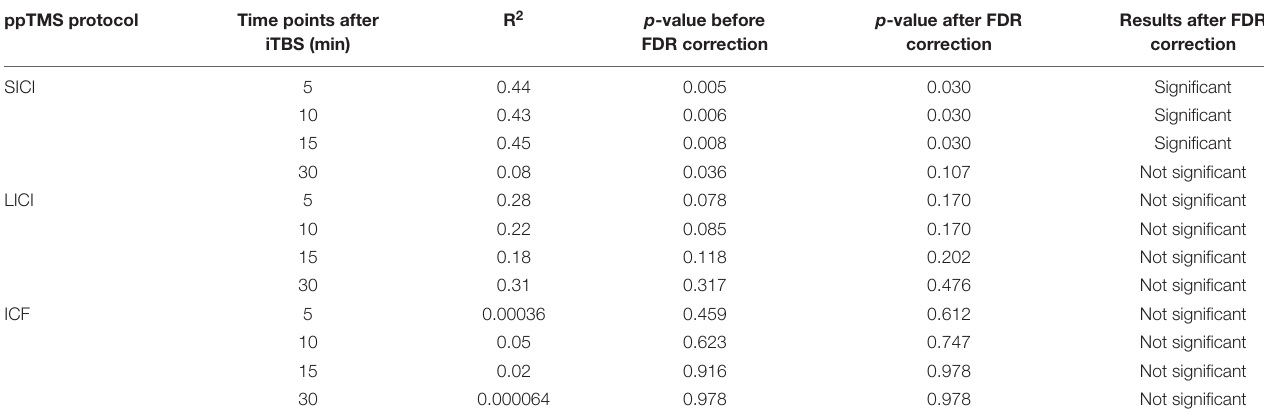
FIGURE 5 | Correlation between intracortical facilitation (ICF) and the after-effect of intermittent theta burst stimulation (iTBS)-induced long-term potentiation (LTP)-like plasticity. (A) No significant correlation was reported between the amount of ICF measured before iTBS and the iTBS after-effect at the time point of 5 min [ R 2 < 0.01, p = 0.612, false discovery rate (FDR) corrected]. (B) There was also no significant correlation between the level of ICF and the after-effect of iTBS-induced LTP-like plasticity at the time point of 10 min ( R 2 = 0.05, p = 0.747, FDR corrected). (C) A non-significant correlation was also reported between the amount of ICF before stimulation and the iTBS-induced effects at 15 min after stimulation ( R 2 = 0.02, p = 0.978, FDR corrected). (D) There was no significant correlation between ICF before stimulation and iTBS-effect at 30 min ( R 2 < 0.01, p = 0.978, FDR corrected). TABLE 1 | Correlation between the level of short-interval intracortical inhibitory (SICI), long-interval intracortical inhibitory (LICI), and intracortical facilitation (ICF) measured before stimulation and the after-effect of intermittent theta burst stimulation (iTBS)-induced long-term potentiation (LTP)-like plasticity (all R 2 and p -values before and after applying the FDR